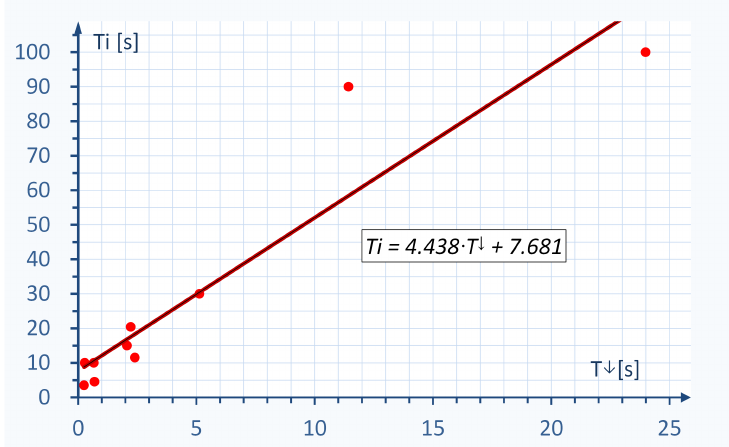
Figure 13. The integration time, T i , versus the effective time constant, T ↓ .